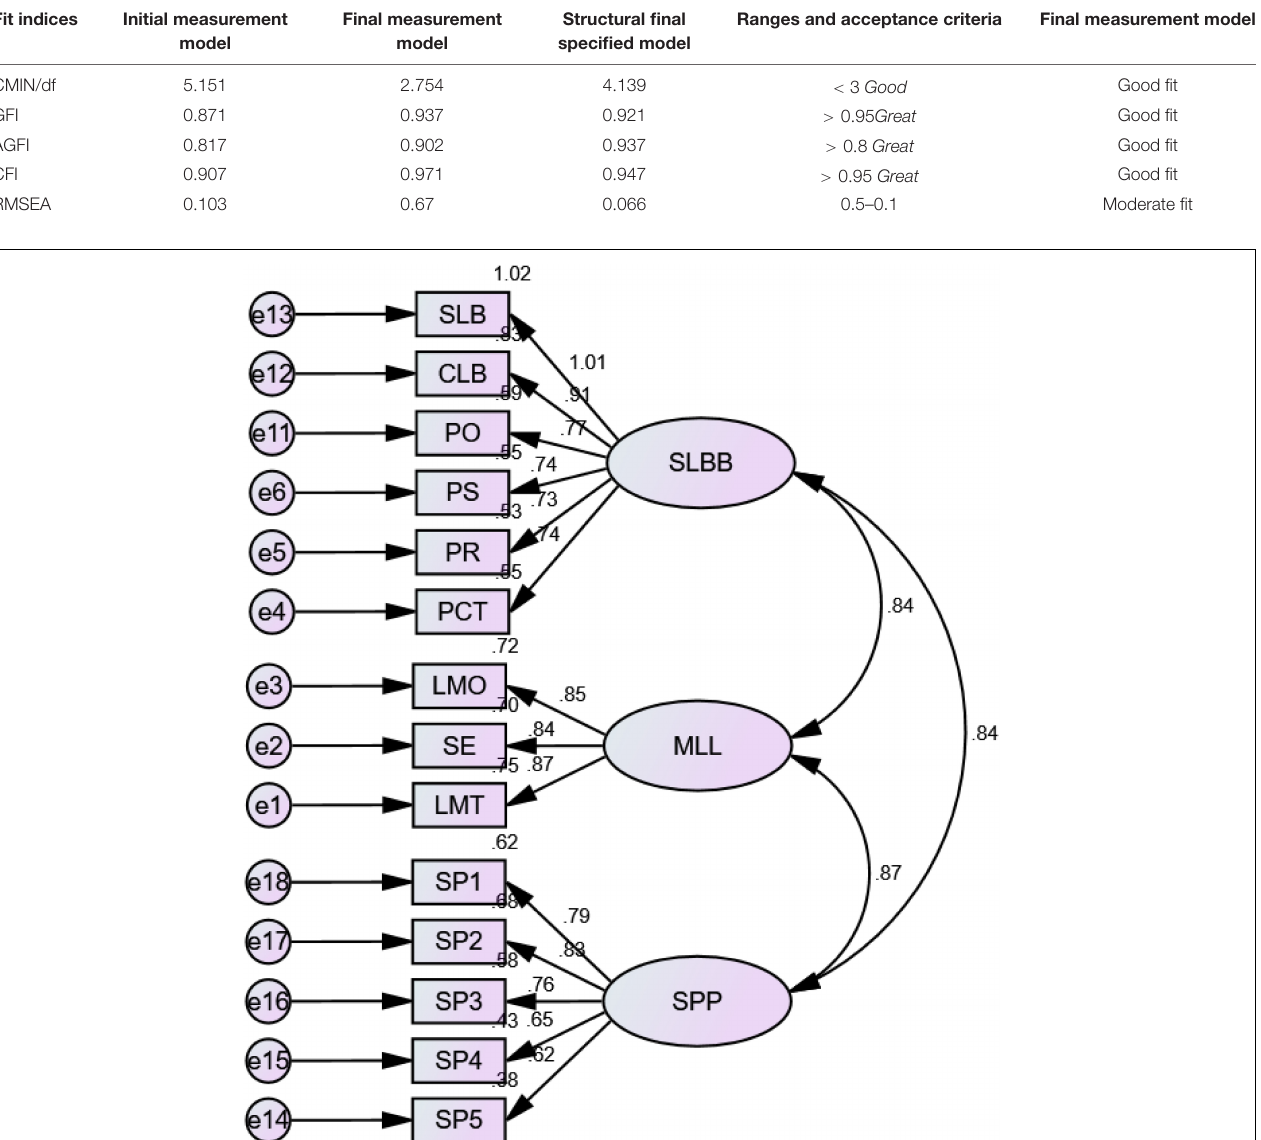
TABLE 4 | Initial measurement, final measurement, and structural models.